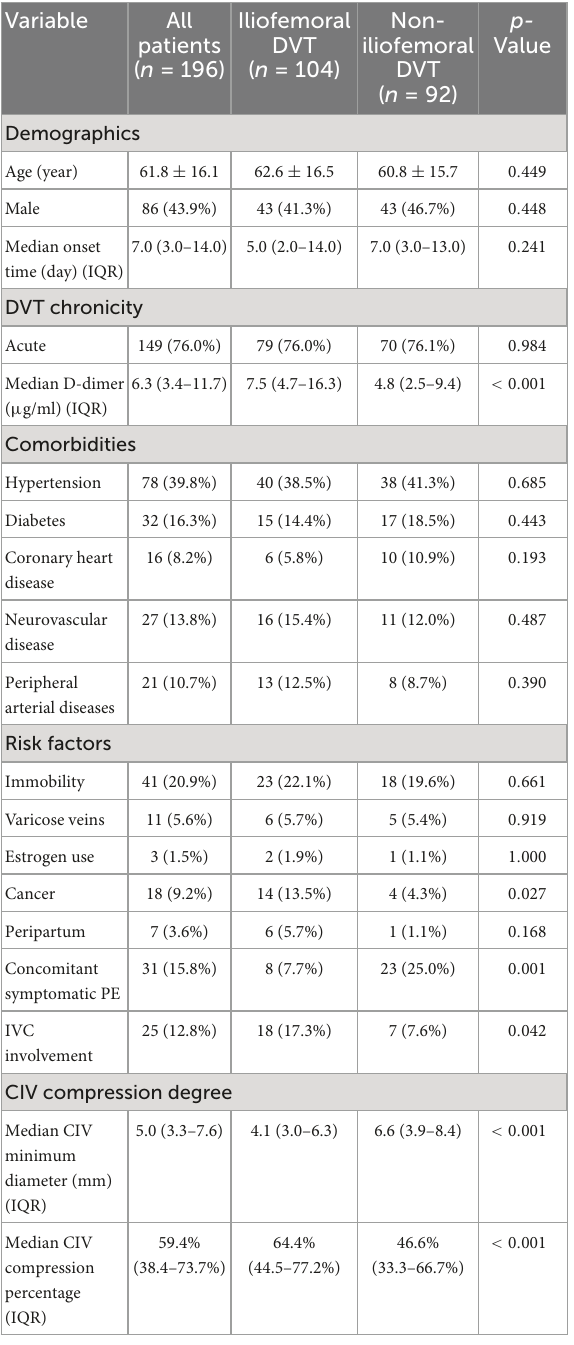
TABLE 1 Demographics, comorbidities, risk factors, and CIV compression degree in patients with and without iliofemoral DVT.